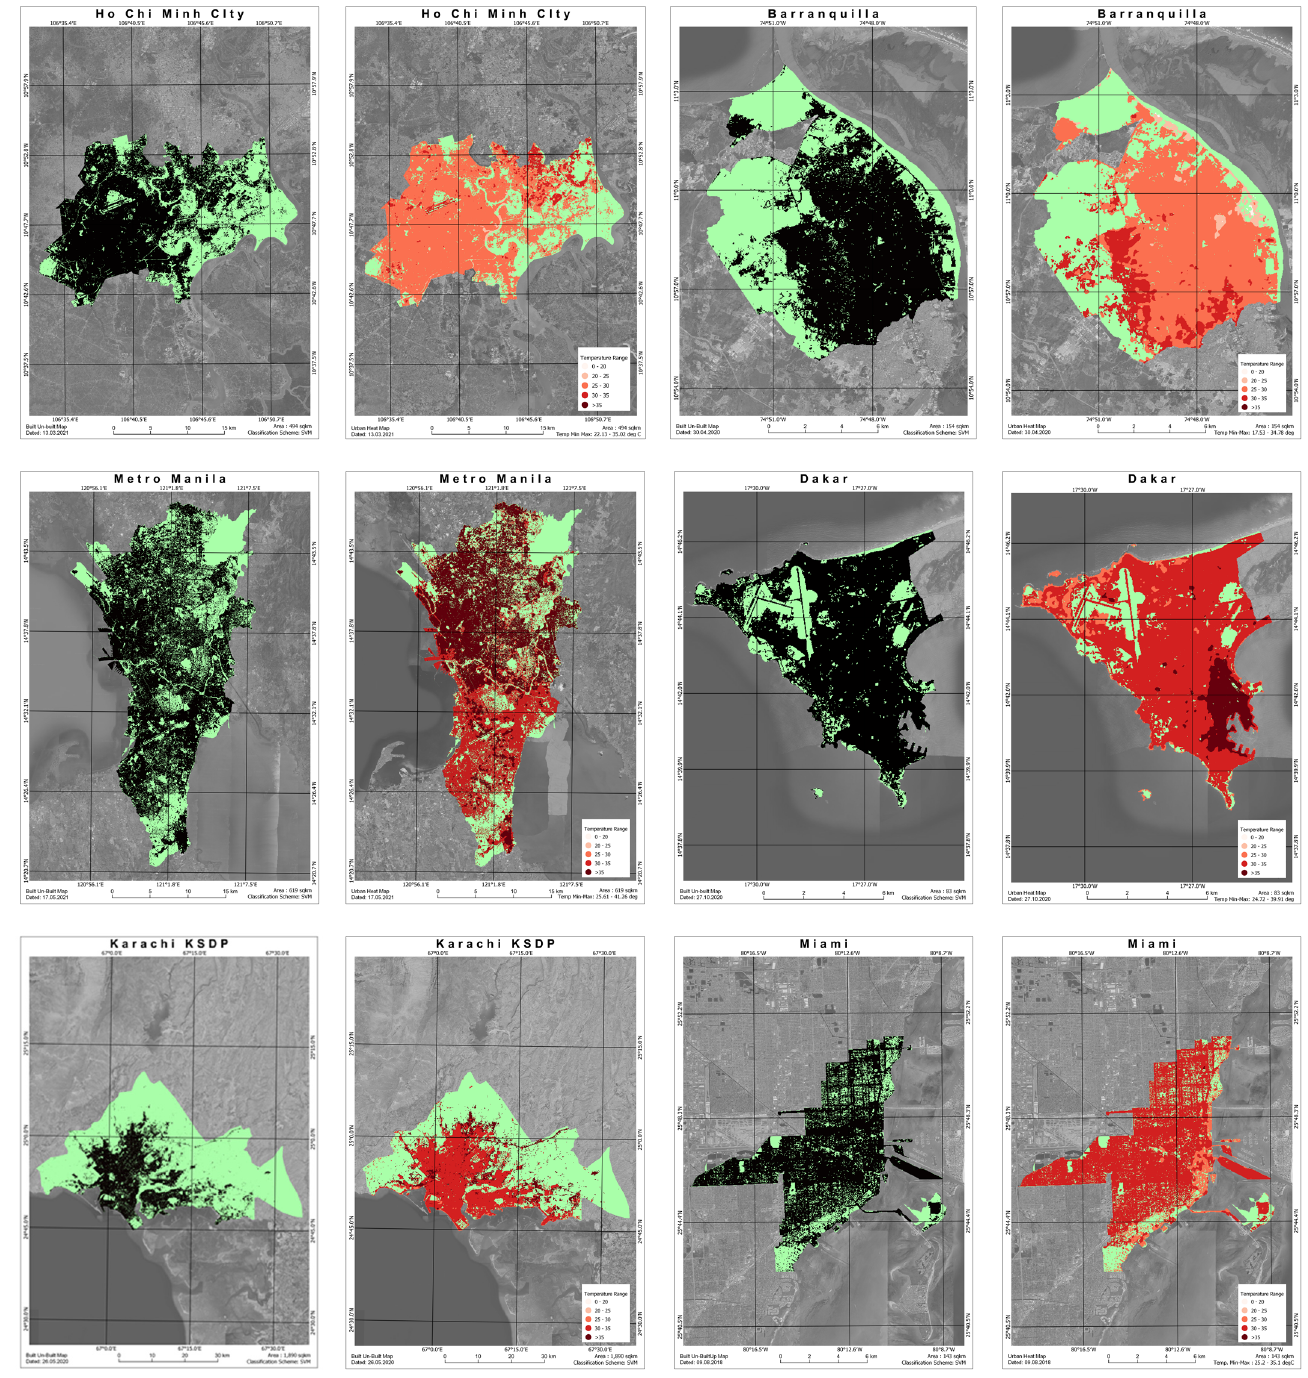
Figure A1. Built/unbuilt maps with corresponding heat maps for both megacities and their respective mid-sized cities, as per the latitudinal reference ( top : Ho Chi Minh City and Barranquilla) ( middle : Manila and Dakar) ( bottom : Karachi and Miami).